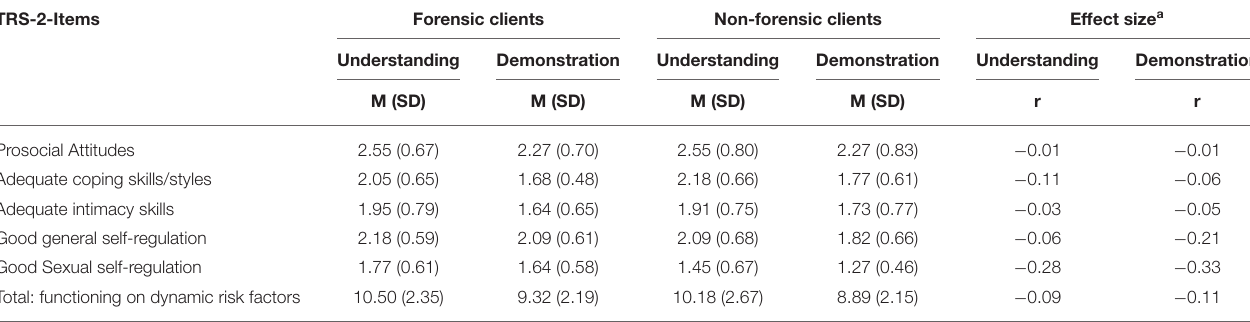
22) and non-forensic clients ( n =